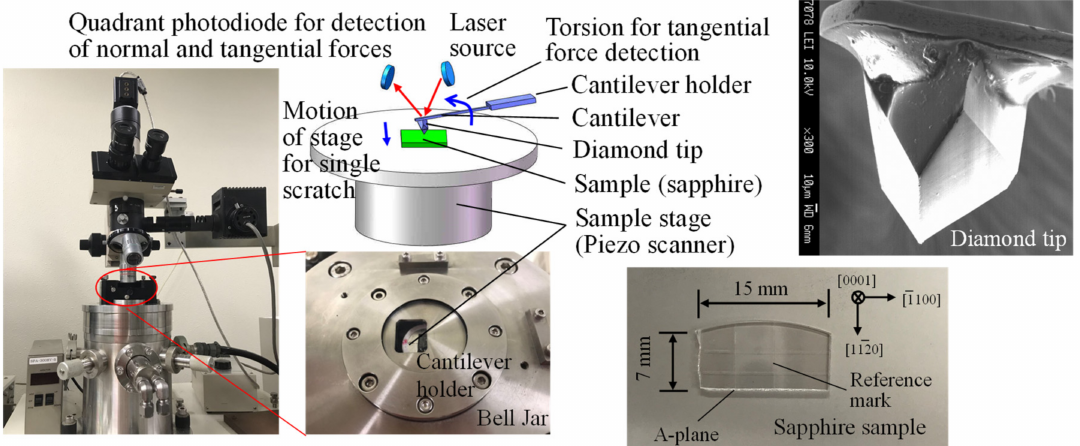
Figure 3. Appearance of SPM and schematic of nanoscratching model using FFM mode with the images of sapphire sample and diamond tip.